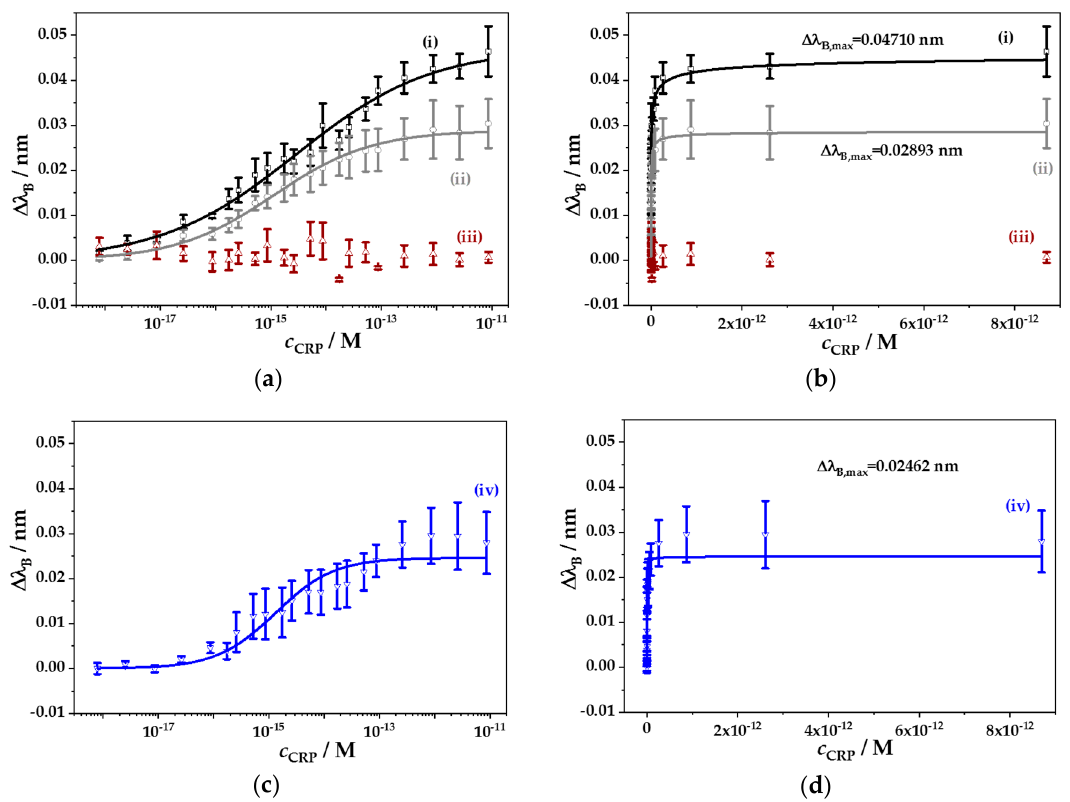
Figure 11. The Bragg wavelength shift ∆ λ B of biofunctionalized eFBG fibers as a function of a CRP concentration range (i) without any interfering substances (black), (ii) in presence of the interfering substances urea (1.8 mg/mL) and ascorbic acid (1.8 mg/mL) (grey), (iii) without fiber coupling of the CRP-specific aptamer and any interfering substance (brown), and (iv) in presence of diluted CRP deficient human plasma (blue). Data were fitted to the Langmuir-Freundlich isotherm according to Equation (6) (solid lines), with fit qualities of (i) R 2 = 0.988, (ii) R 2 = 0.989, and (iv) R 2 = 0.951, respectively. Data of ∆ λ B vs. c CRP are shown in a semi-logarithmic plot ( a , c ), as well as in a linear plot ( b , d ) to indicate the asymptotic characteristic of ∆ λ B within the CRP concentration range. Means ± SEM for (i) N = 5, (ii) N = 8, (iii) N = 3, and (iv) N = 3.